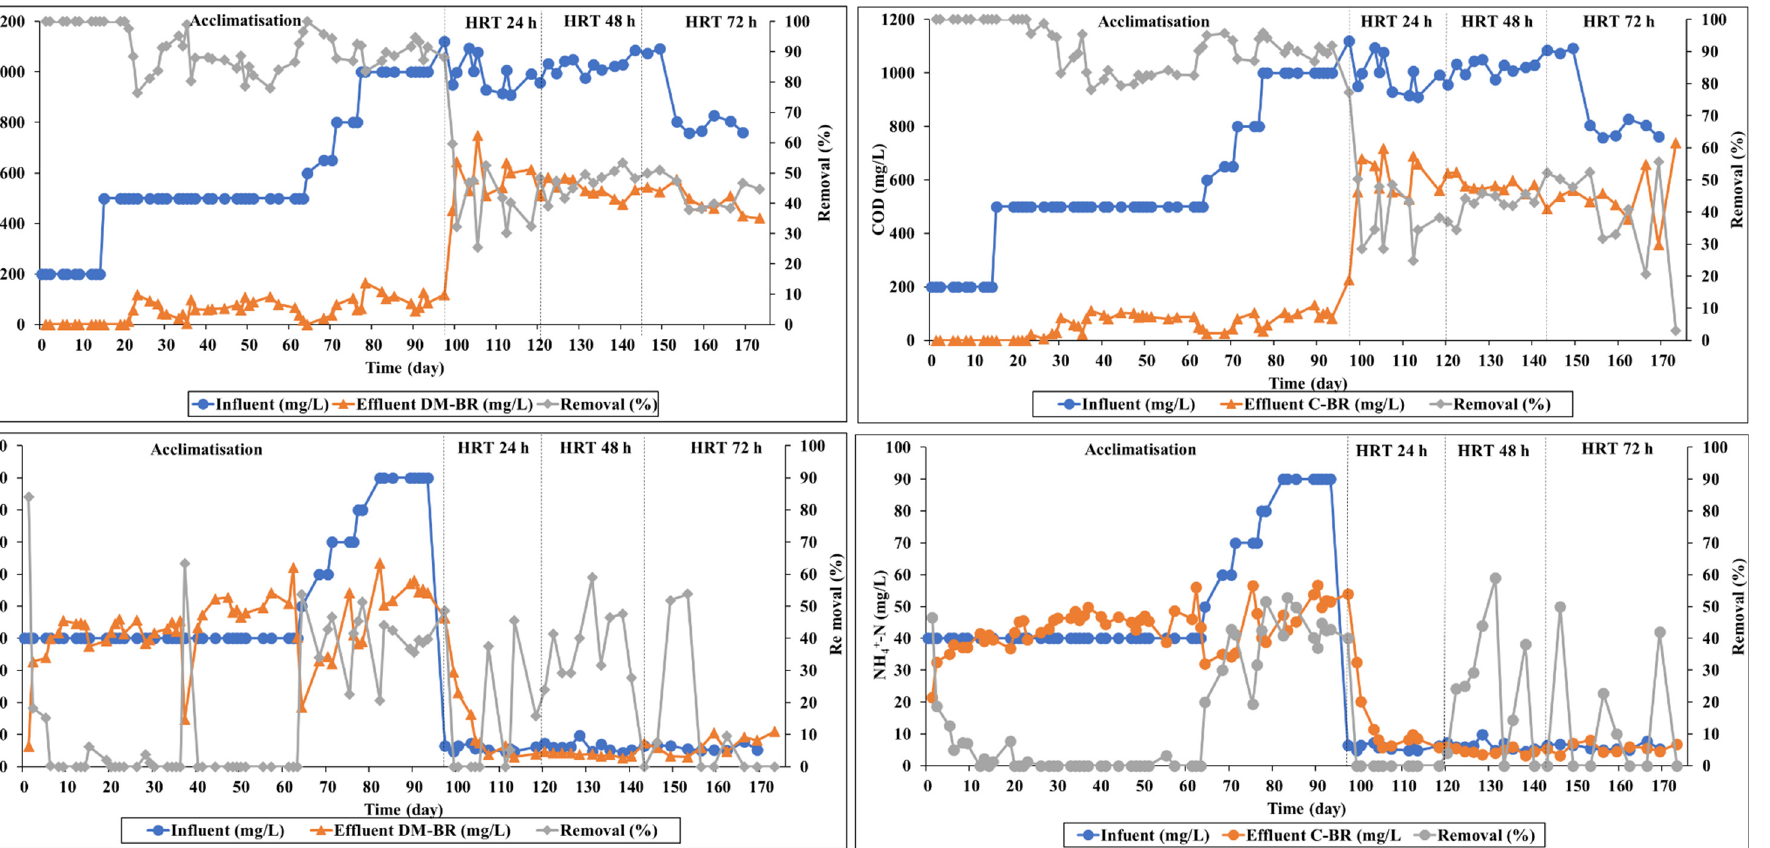
Figure 3. Removal of ( a ) COD and ( b ) NH4+-N in the DM-BR (left) and the C-BR (right).